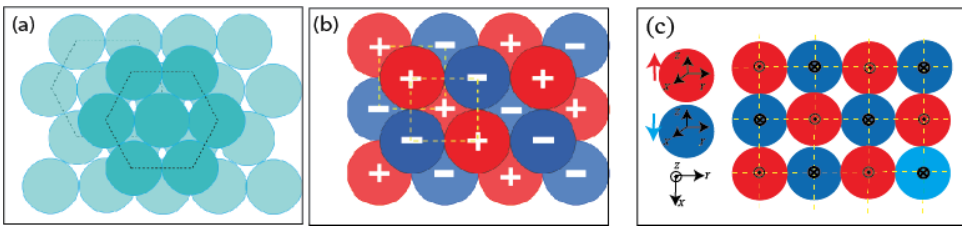
Figure 6. Schematic illustration of ZnO microdroplet organizations in hexagonal ( a ) and square ( b , c ) lattices. In ( c ), the ‘ · ’ dot sign surrounded by a circle in red spheres represents an electric dipole oriented upwards (along the direction of the z-axis), whereas the ‘ × ’ cross sign surrounded by a circle in blue spheres represents a downward-oriented electric dipole (along the opposite direction of the z-axis).